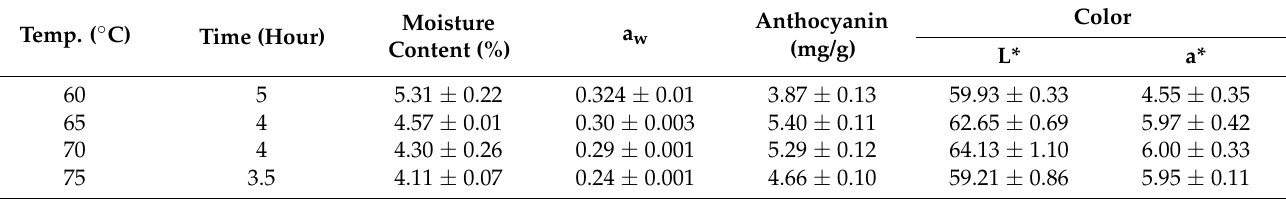
Table 5. Quality of mulberry powder at different drying temperatures and